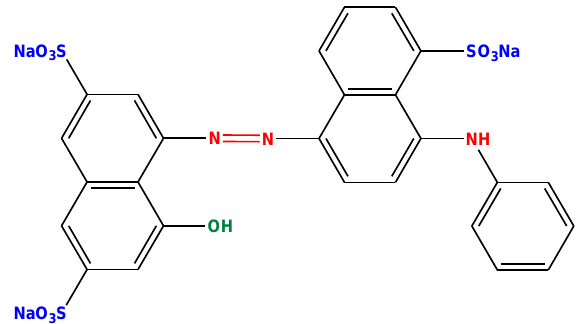
Figure 1. Structure of